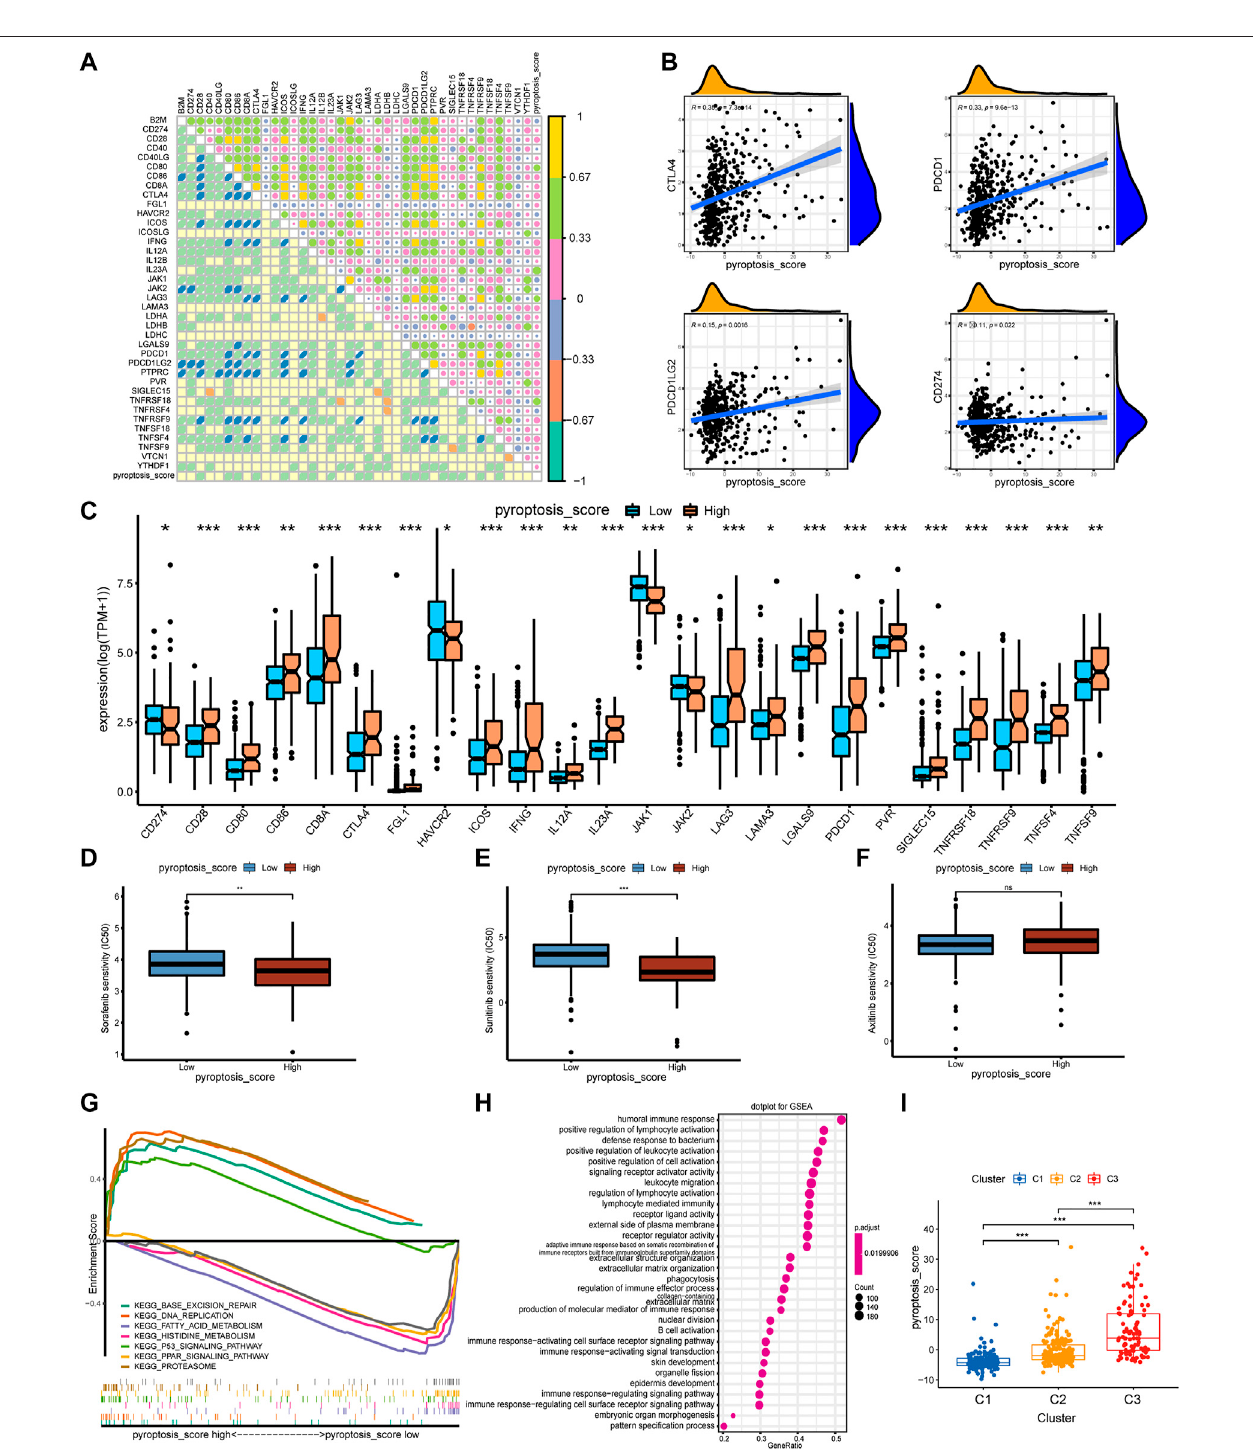
FIGURE 5 | The correlation of pyroptosis-score with immune checkpoints and drug response, and the biological process of grouping. (A) Spearman correlation coef fi cient diagram of pyroptosis-score and common immune checkpoints. (B) Spearman correlation scatter plot between pyroptosis-score and CTLA4, PDCD1, PDCD1LG2, and CD274. (C) The different expression levels of common immune checkpoints between the high and low pyroptosis-score groups. (D – F) The different IC50 of the targeted drugs among high and low pyroptosis-score. (G,H) GSEA enrichment analysis of high and low pyroptosis-score groups, including KEGG pathways (G) , and GO annotation (H) (*** p < 0.001, ** p < 0.01, * p < 0.05). (I) The pyroptosis-score of the three pyroptosis subtypes.